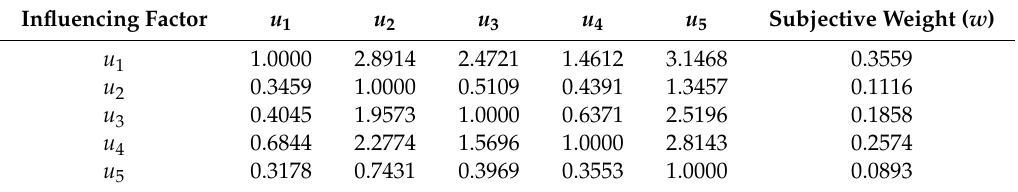
Table 14. The subjective weights of the intelligent substation SCADA system influencing factors.